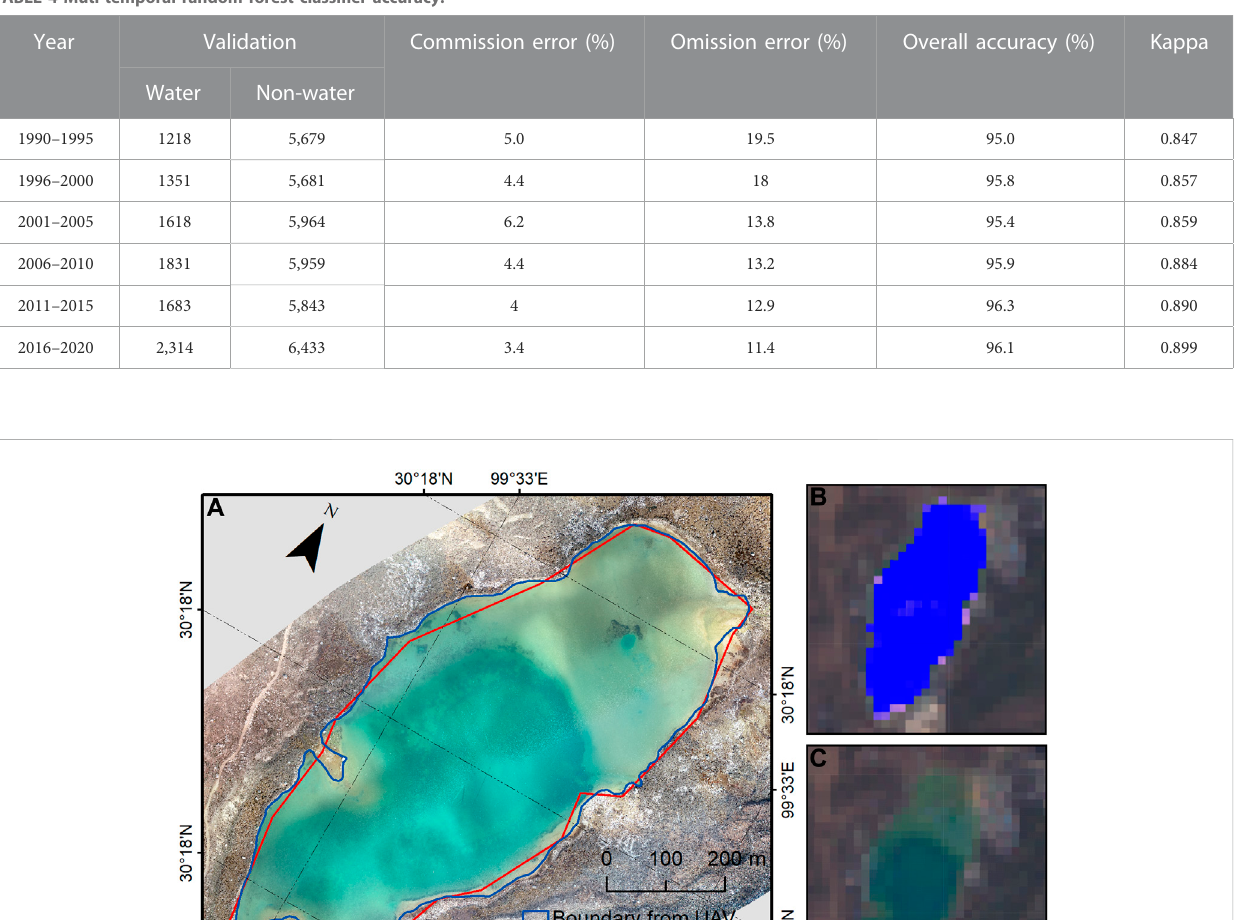
TABLE 4 Muti-temporal random forest classi fi er